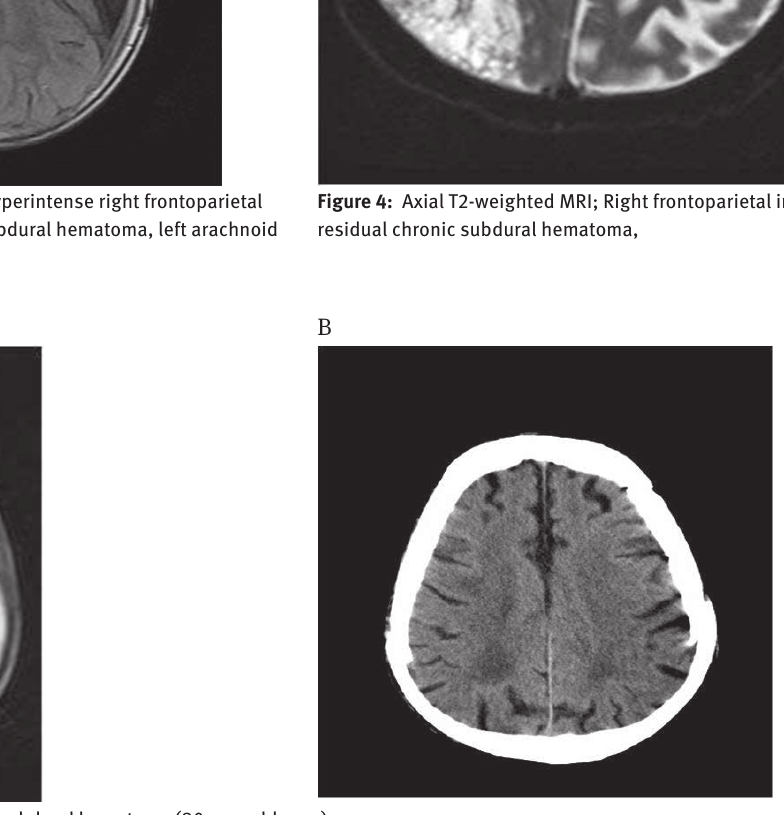
Figure 5: Bilateral residual chronic subdural hematoma (80 year old case); A: Preoperative, Axial T1-weighted MRI; Bilateral hyperintense parietal subdural hematoma B: Postoperative, Computed Tomography (CT); Disappearance of subdural